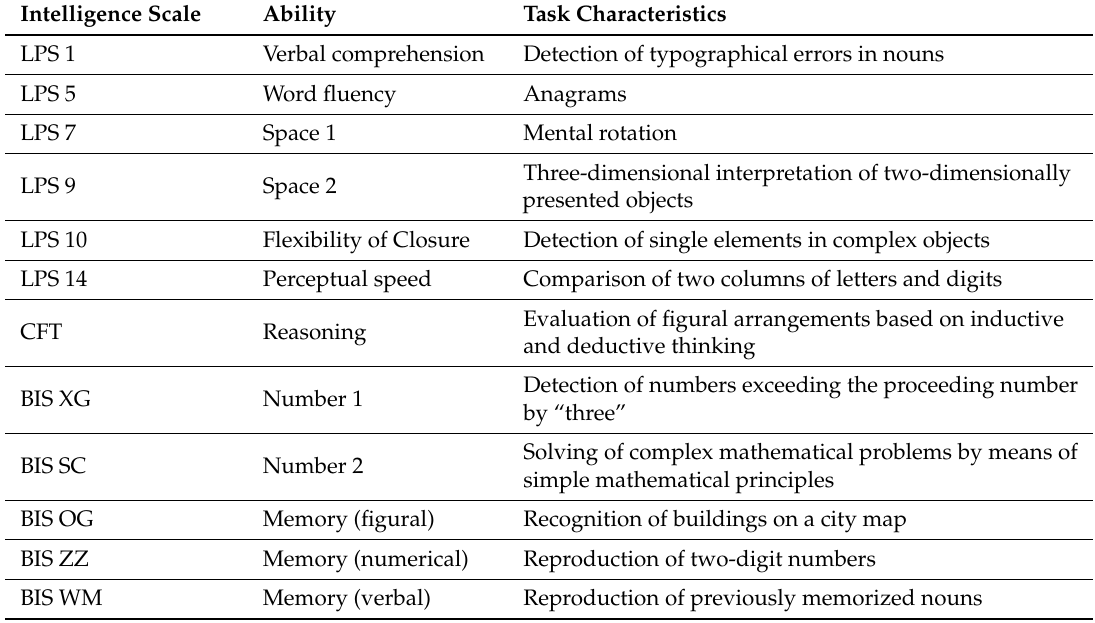
Table 1. Description of psychometric tests applied for measuring primary mental